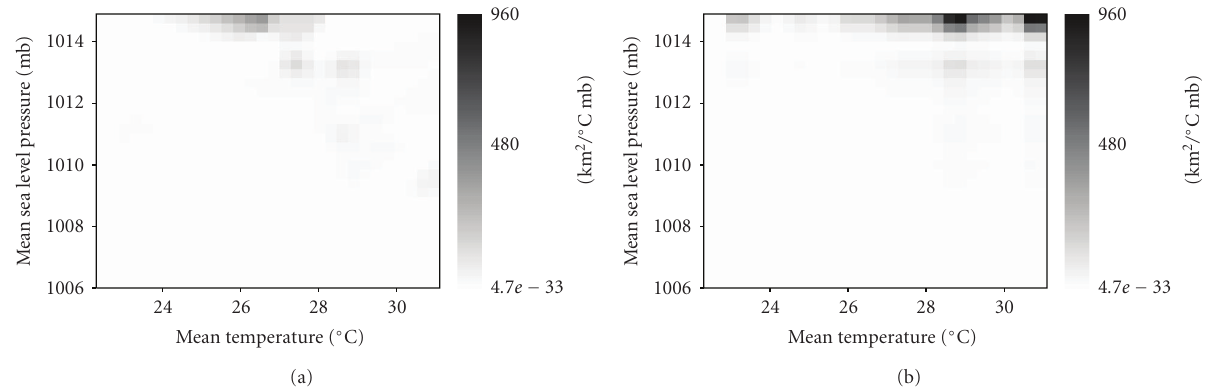
Figure 4: Kernel estimates of daily burn area as a function of mean temperature and mean sea level pressure: (a) nonseparable kernel estimate; (b) separable kernel estimate.